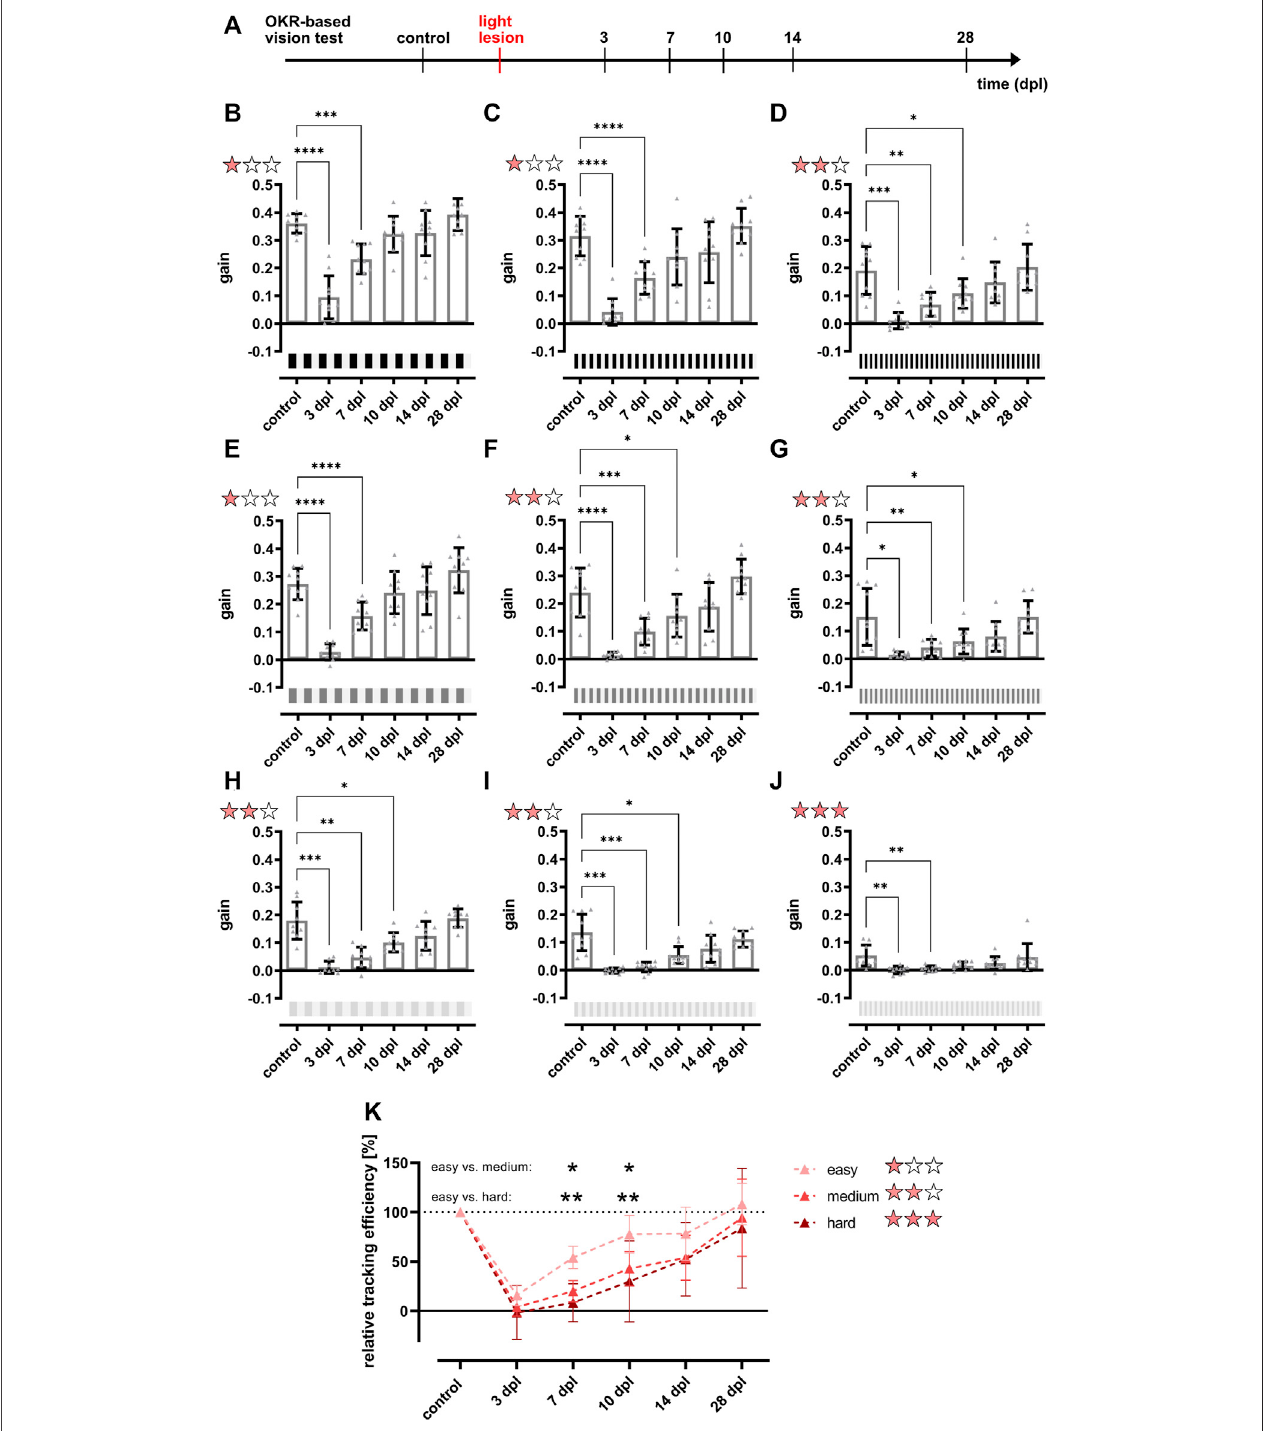
FIGURE 5 | The restoration of the full optokinetic response is accomplished between 10 and 14 days after light lesion dependent on the degree of dif fi culty. (A) Experimentaltimeline.Theoptokineticresponse(OKR)-basedvisiontestwasperformedbeforethelightlesion(control)andat3,7,10,14,and28 dayspostlesion(dpl). (B – J) Quanti fi cations ofthe gain obtained for a black-white stimulus at a constant angular velocity of 15 dps but different combinations ofcontrast and spatial frequency revealed thatthegaindroppedsigni fi cantlyat3 dplandremainsstrikinglyreducedat7 dplatallconditions.Foreasyconditionswithhighcontrastandlowspatialfrequency(one red star), pre-lesion levels are reached at 10 dpl, whereas the OKR for medium dif fi culty (two red stars) returned to pre-lesion levels from 14 dpl onwards. Under hard conditions(threeredstars)withlowcontrastandhighspatialfrequency,thegainwasalreadyverylowatcontrolrecordingsbutstatisticallyrecoveredby10 dpl.Allindividual